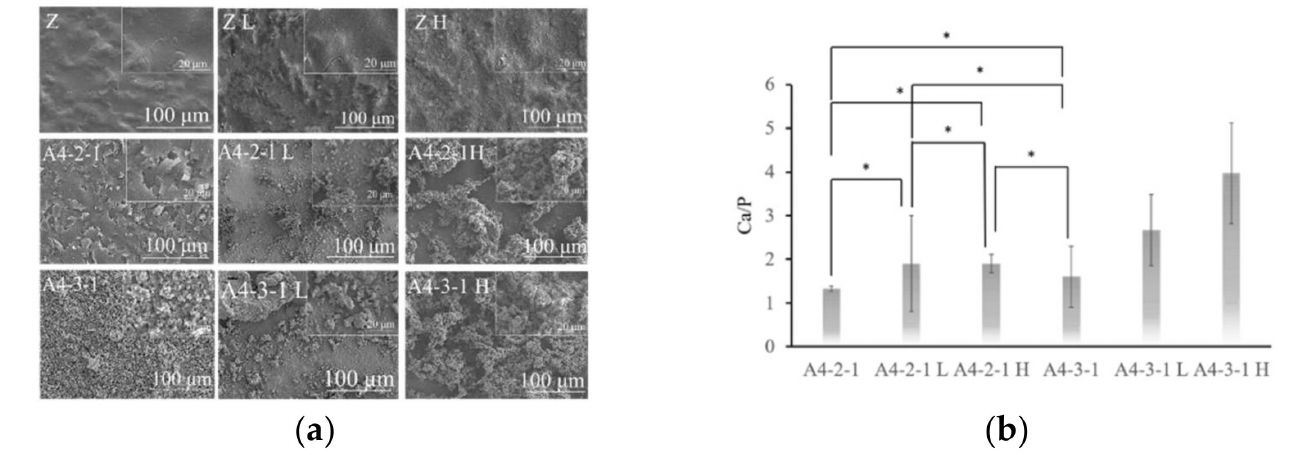
Figure 12. ( a )The surface morphology of sintering samples was observed via SEM. ( b ) It was found by EDS that the calcium phosphorus compound was contained on the surface of the sintered material. The calcium-phosphorus ratio (Ca/P) shows the composition of calcium-phosphorus compounds (* p < 0.05).